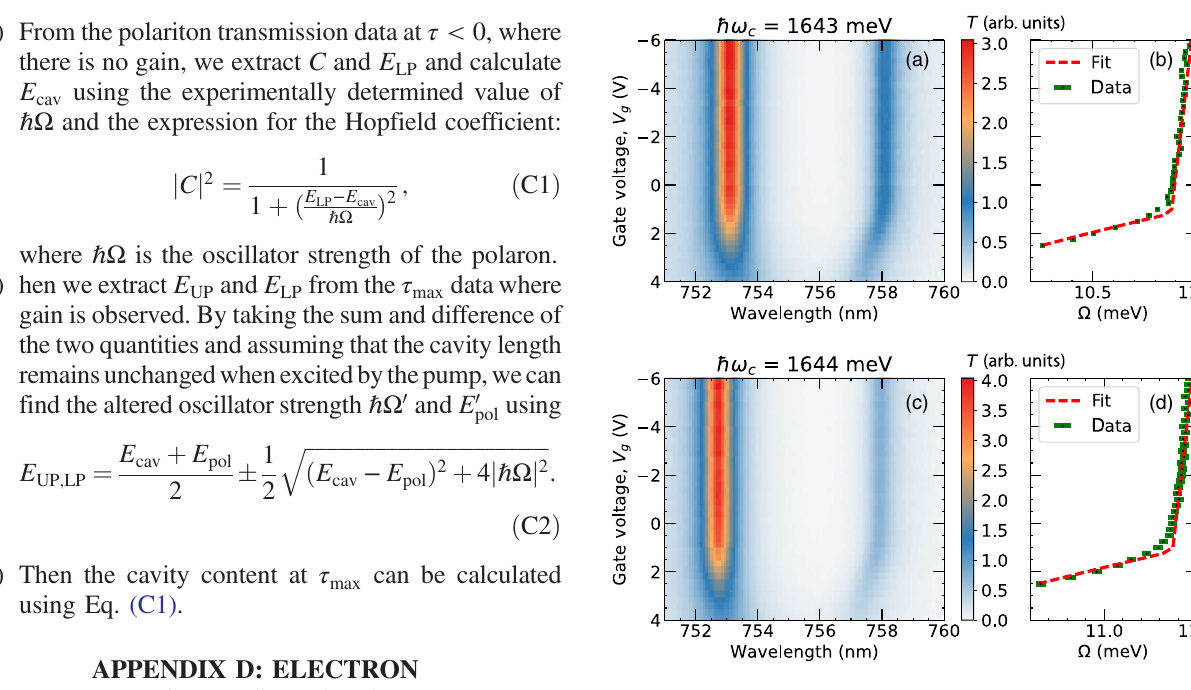
FIG. 8. (a) Transmission T spectrum of the repulsive polaron- polariton as a function of V at a bare cavity mode energy of g ℏ ω ¼ 1643 meV. (b) Black dots with green error bars: Rabi c splitting extracted from Lorentzian fits to the transmission spec- trum. The red dashed line is a fit of the model detailed in the text to ¼ 1644 the data. (c),(d) Analogous to (a),(b) for ℏ ω c